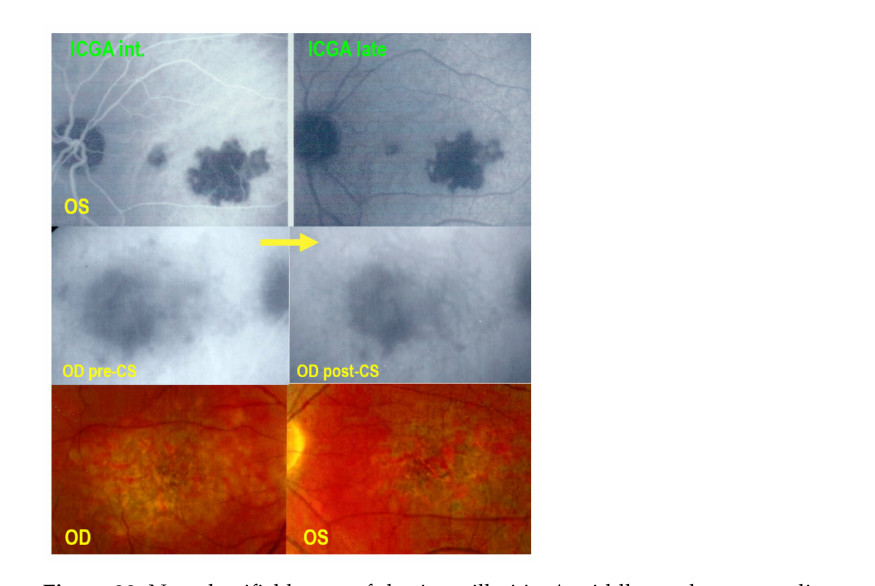
Figure 20. Non-classifiable case of choriocapillaritis. A middle-aged man was diagnosed as “unilateral APMPPE” OS ( Top two frames) with a severe drop of vision after a flu-like episode. The doctors refrained from immunosuppressive treatment as “APMPPE is a self-limited disease” but macular atrophy ensued ( bottom two frames). His right eye underwent the same evolution, less than a month later and the patient consulted another hospital where again nothing was undertaken as “APMPPE is a self-limited disease”. We saw the patient a few weeks later with macular atrophy OS and partial atrophy with choriocapillaris non-perfusion on ICGA OD ( middle left picture- pre- CS) Systemic corticosteroid therapy was started, allowing to recover some areas of non-perfusion ( middle right -post CS), but with a final low visual acuity. The first ICGA ( top two frames) clearly showed choriocapillaris disease, which could, however, not be classified into one of the known